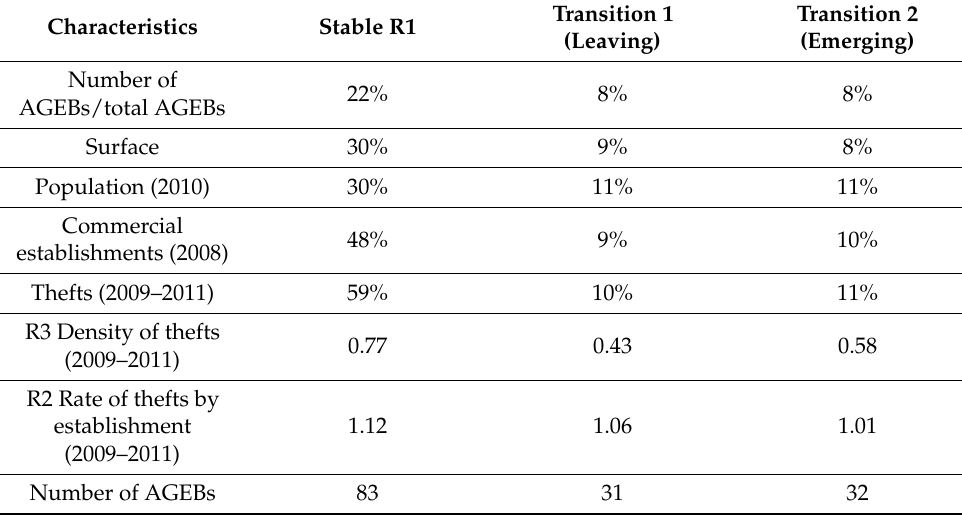
Table 2. Characteristics of stable and transition hot